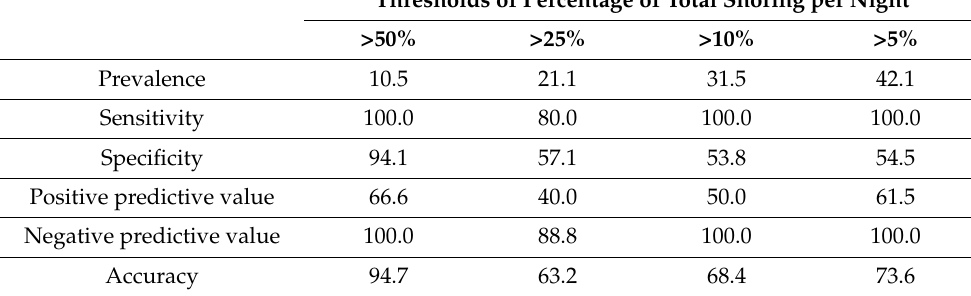
Table 3. Prevalence, sensitivity, specificity, positive predictive value, negative predictive value and accuracy of snoring detection by the SnoreLab app relative to polygraphy (used as gold standard). Snoring was classified as present if the different threshold levels of total snoring per night were exceeded. Values are given in percentage